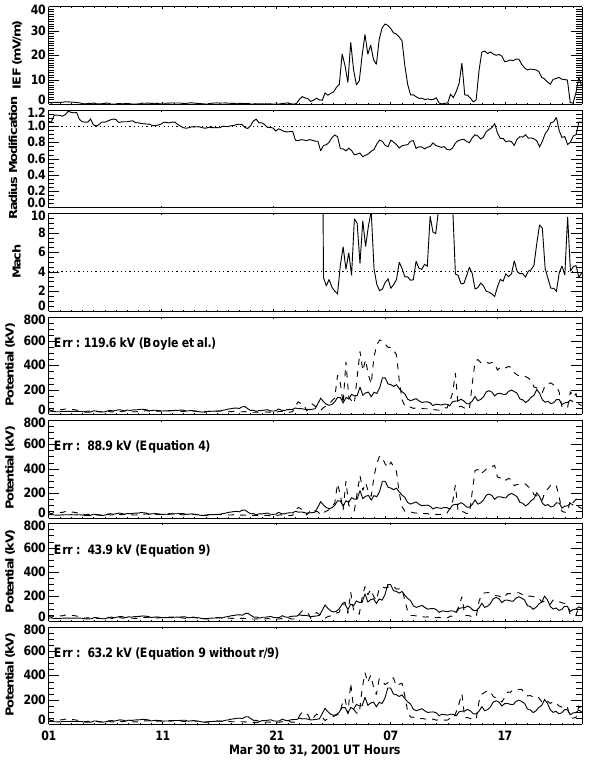
Fig. 9. From top to bottom: the reconnection electric field, using Equation 2; the magnetospheric radius divided by 9; the solar wind Alfv´en Mach number; the AMIE cross polar cap potential (CPCP, solid) and the estimated CPCP using Equation 4; and the AMIE CPCP (solid) and the estimated CPCP using Equation 9. The time period is March 30-31, 2001.